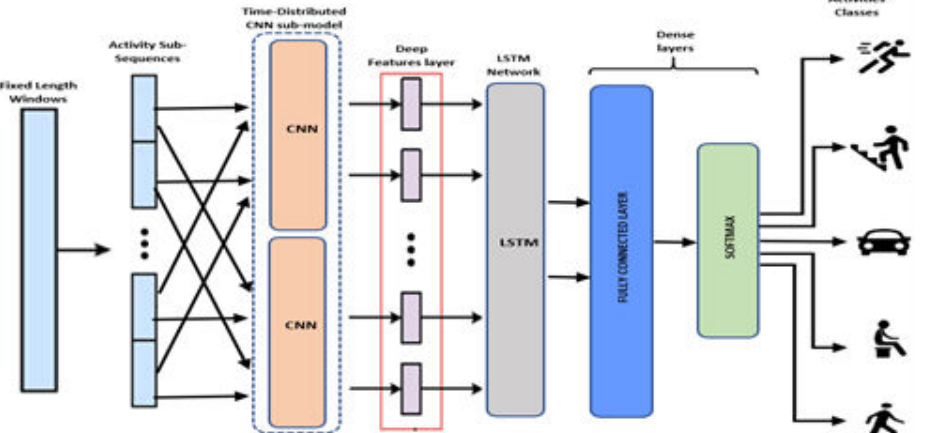
Figure 3. Overview of the proposed context-aware smartphone-based human activity recognition using hybrid CNN–LSTM